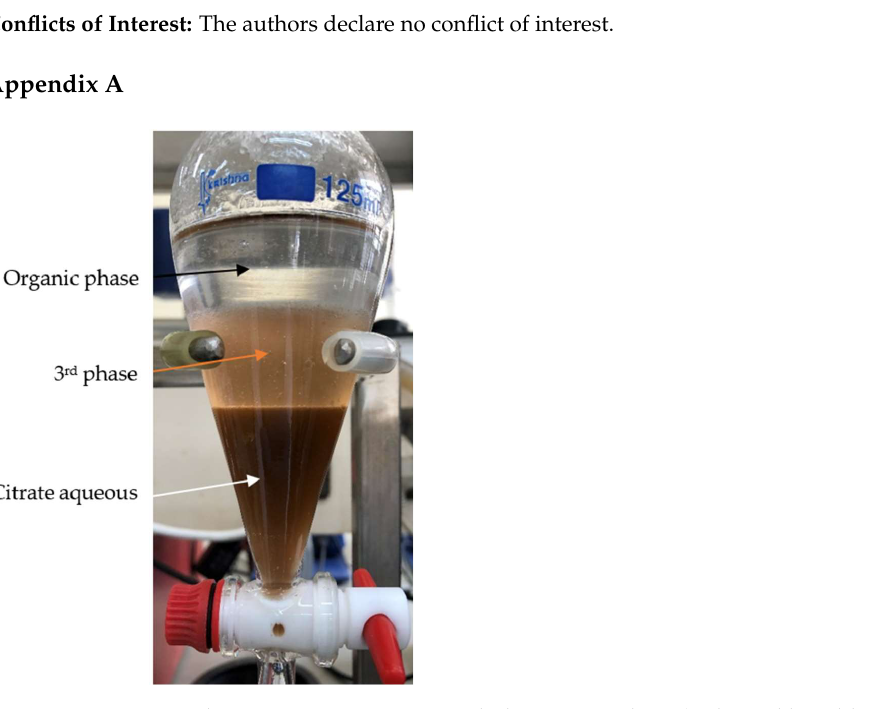
Figure A1. Ternary solvent extraction system with the organic phase (indicated by a black arrow), third phase (indicated by an orange arrow), and aqueous phase (indicated by a white arrow).